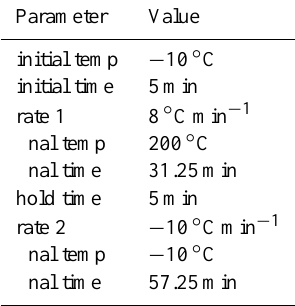
Table 1. Parameters for the GC